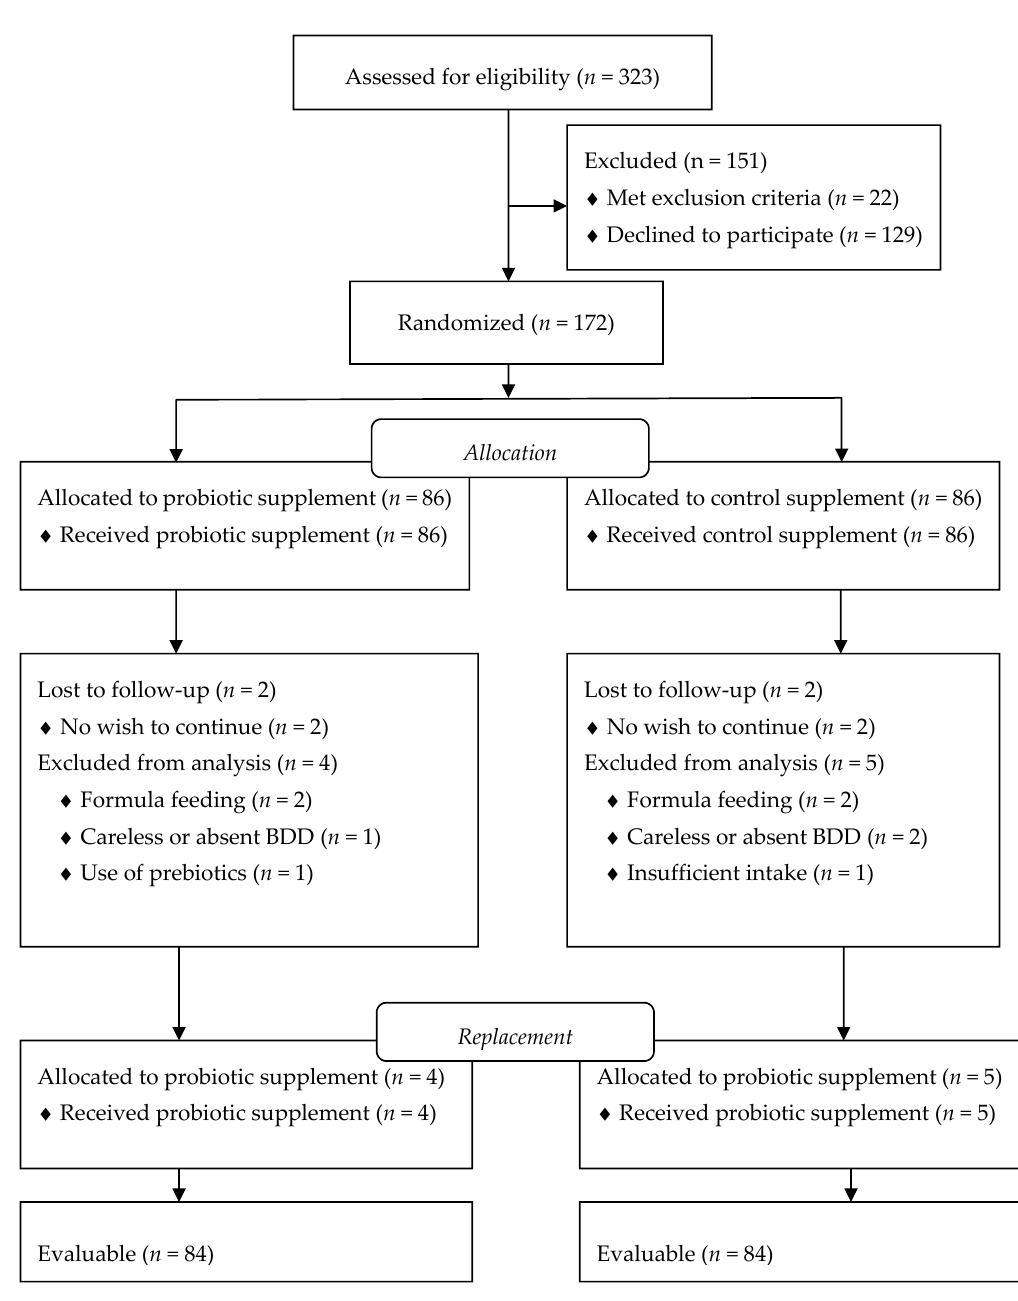
Figure 1. The Consolidated Standards of Reporting Trials flow diagram of the study participants. BDD: Baby`s Day Diary.